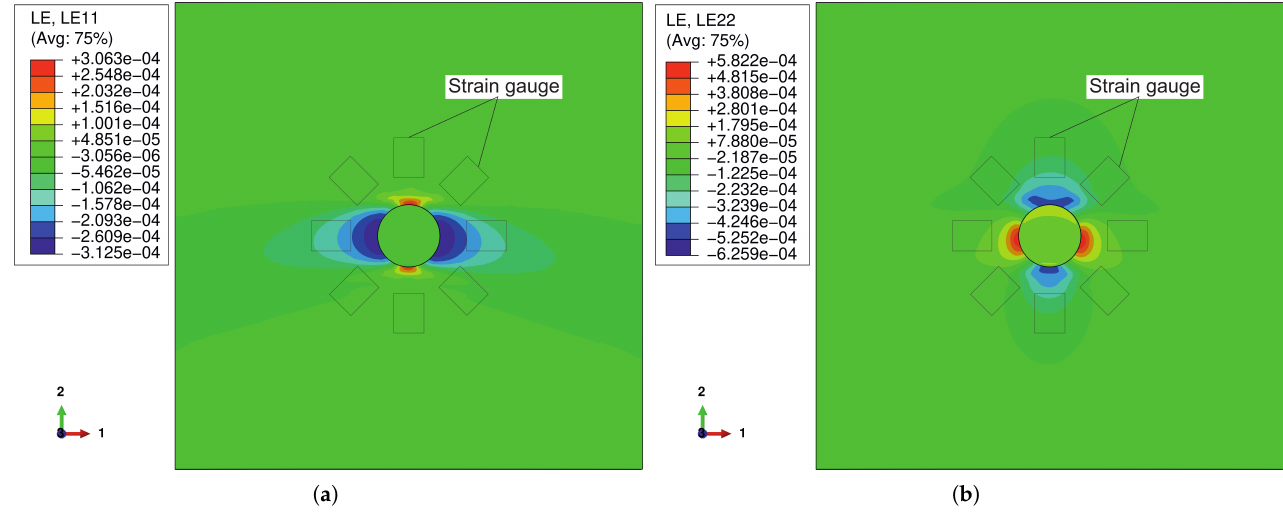
Figure 7. Contour plot of the strain distribution (( a ) ε 11 , ( b ) ε 22 ) around the borehole at a drilling depth of 0.8mm. The placement of the strain gauges is shown in the figures. Due to the (in-plane) fiber waviness, the strain distribution around the borehole is not